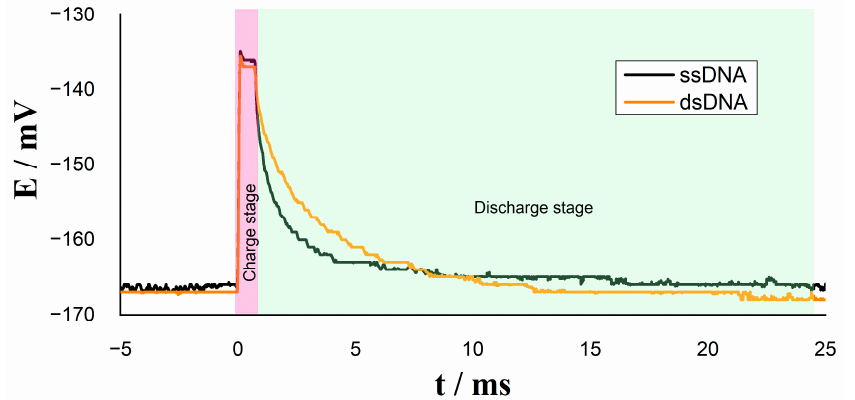
Figure 5. Relaxation voltage without external capacitor C out on Au/ssDNA and Au/dsDNA electrodes.